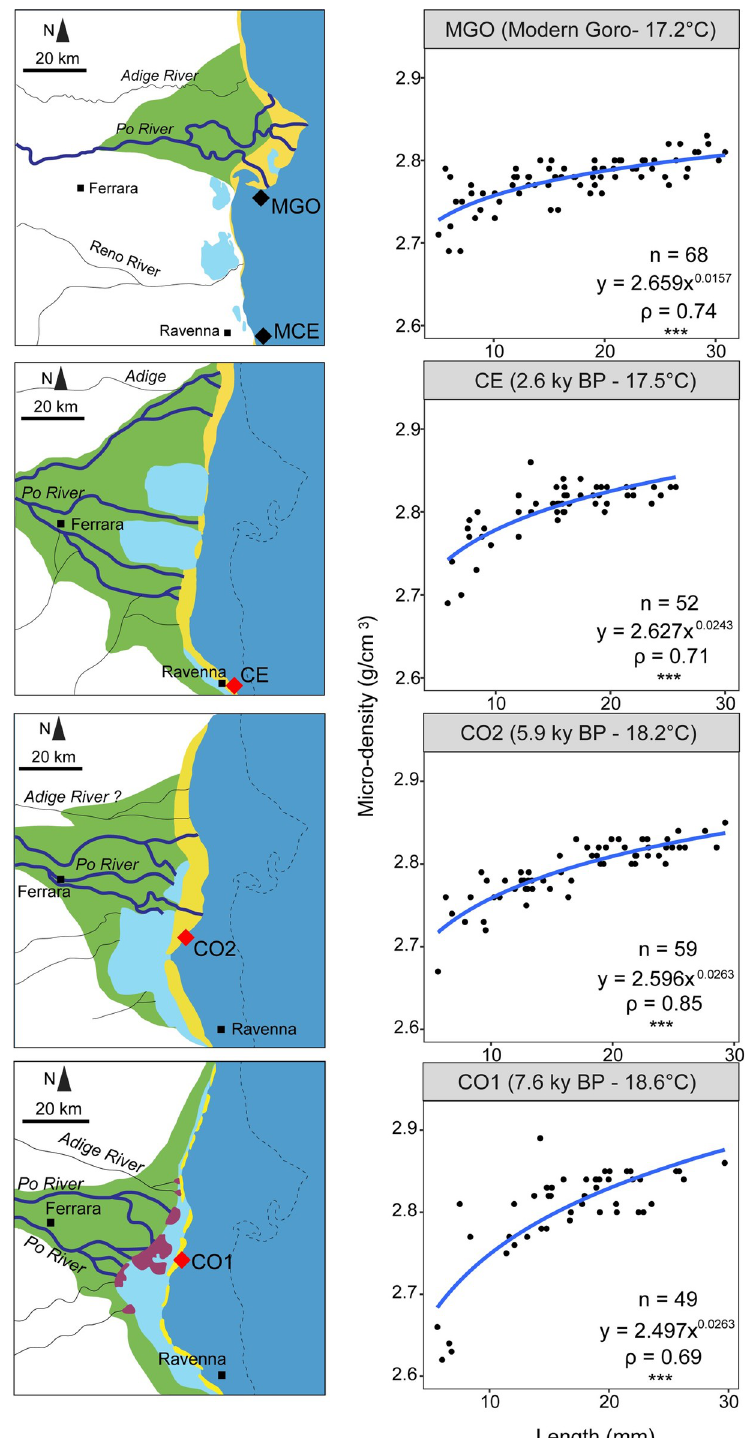
Fig 5. Po coastal plain changes through time and variation in micro-density recorded within the five horizons investigated. Of the two modern settings, only Goro (MGO) data are reported since they show comparable patterns and SSTs (all analyses are shown in S1 Fig in S1 File). The dotted line represents the modern coastline. n = number of valves; ρ = Spearman’s determination coefficient; � p < 0.05; �� p < 0.01; ��� p < 0.001. Geomorphologic map after Amorosi et al . [13, 14], slightly modified and for illustrative purposes